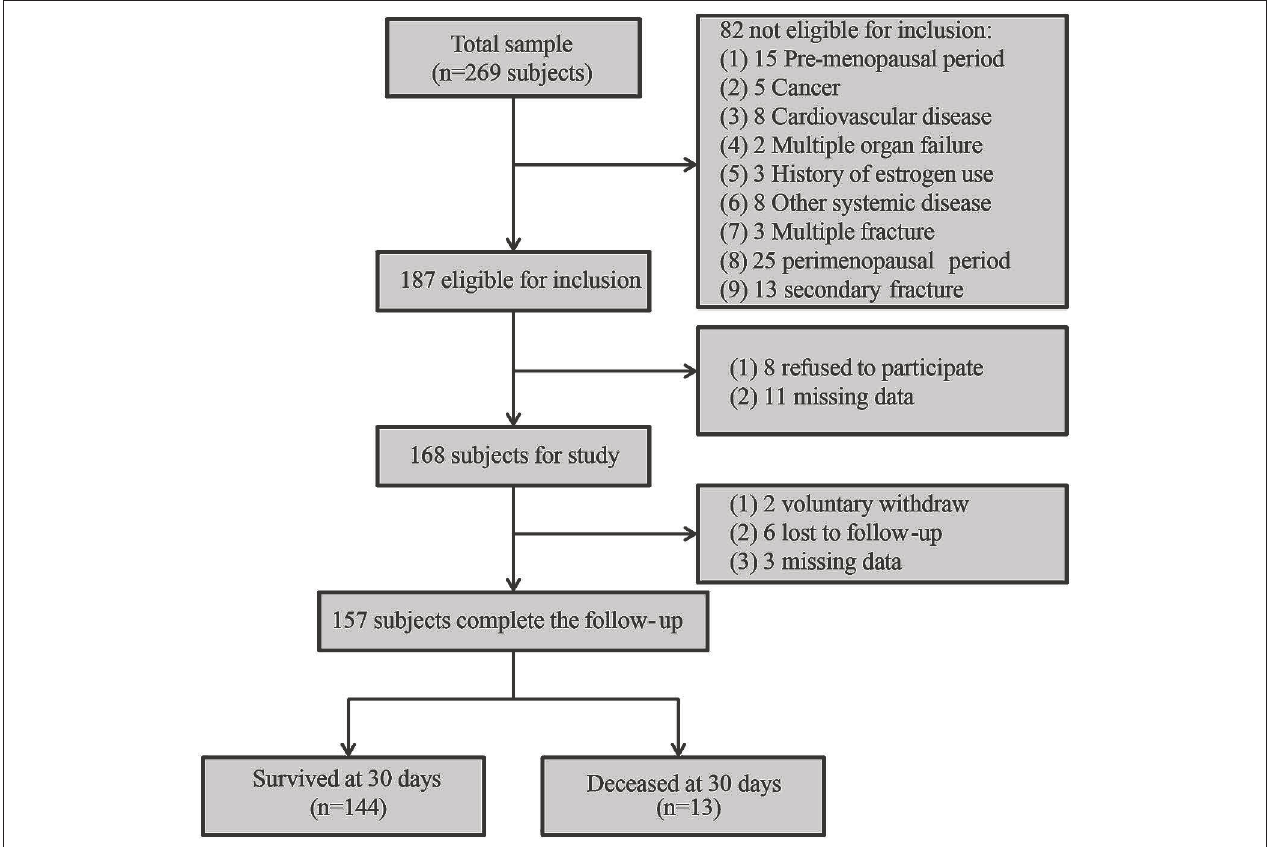
FIGURE 1 | The study cohort flow